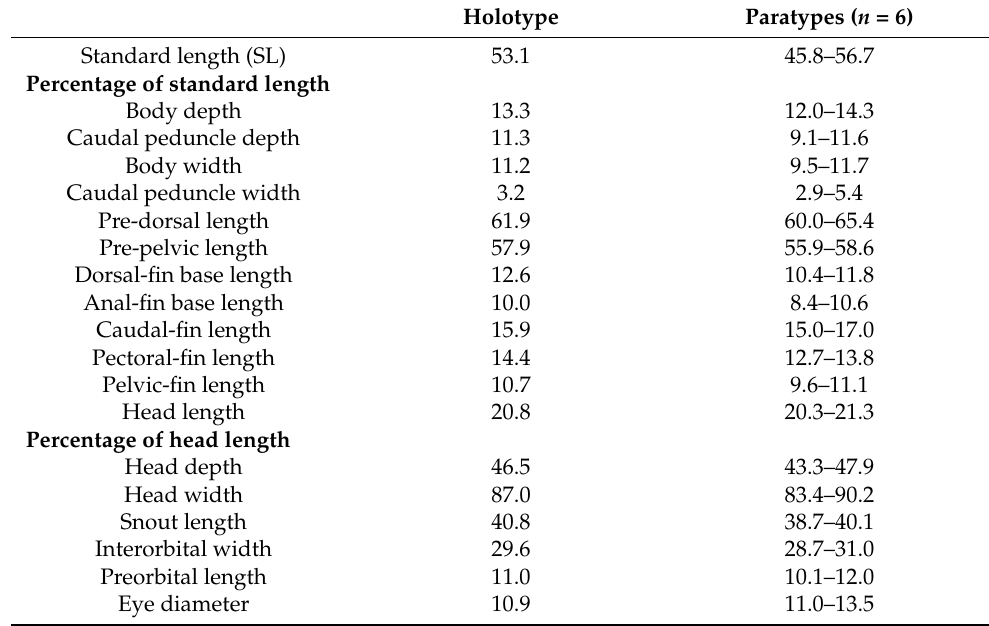
Table 1. Morphometric data of Trichomycterus saquarema Costa, Katz, Vilardo and Amorim sp.